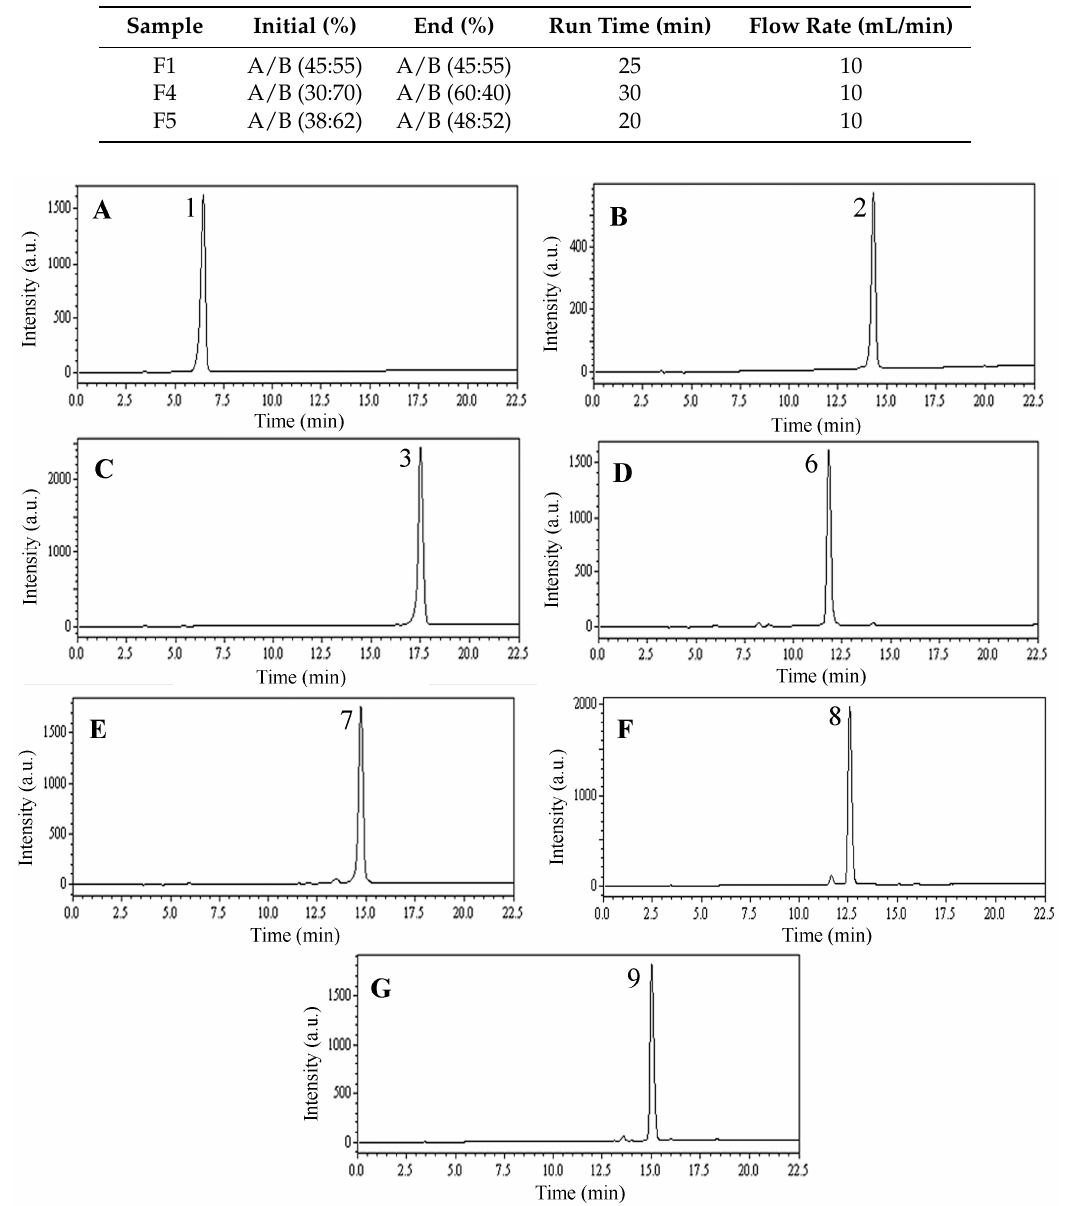
Figure 5. HPLC chromatograms of prep-HPLC peak fractions. ( A : chlorogenic acid, compound 1 in Figure 4A; B : lonicerin, compound 2 in Figure 4A; C : rutin, compound 3 in Figure 4A; D : 3,4- O - dicaffeoylquinic acid, compound 6 in Figure 4D; E : hyperoside, compound 7 in Figure 4D; F : 3,5- O - dicaffeoylquinic acid, compound 8 in Figure 4E; G : 4,5- O -dicaffeoylquinic acid, compound 9 in Figure 4E). a.u.: arbitrary